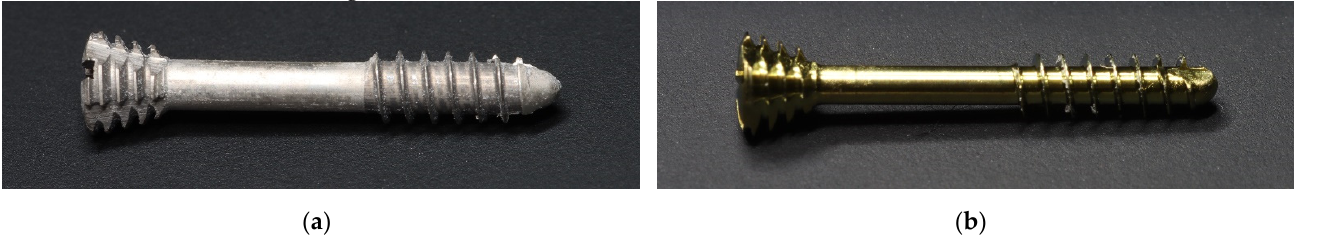
Figure 1. General appearance of the compressive headless screws used in the study. These screws are ChM's dedicated designs for mandibular head fixation. ( a ) magnesium alloy 2.2 mm screw (test group); ( b ) titanium alloy 1.7 mm screw (reference group). Compressibility is ensured by different thread pitch. The large pitch at the tip of the screw ensures a large longitudinal movement with every turn in proximal bone fragments. On the other hand, a small thread pitch at the socket end leads to a small longitudinal movement of the screw in distal bone fragments, which ensures a compression effect in the fracture gap.